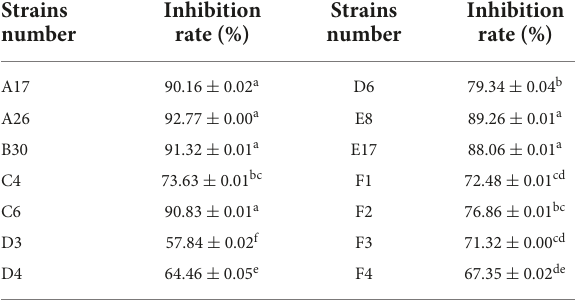
TABLE 3 Inhibition rate of different Trichoderma strains against Sclerotinia asari .